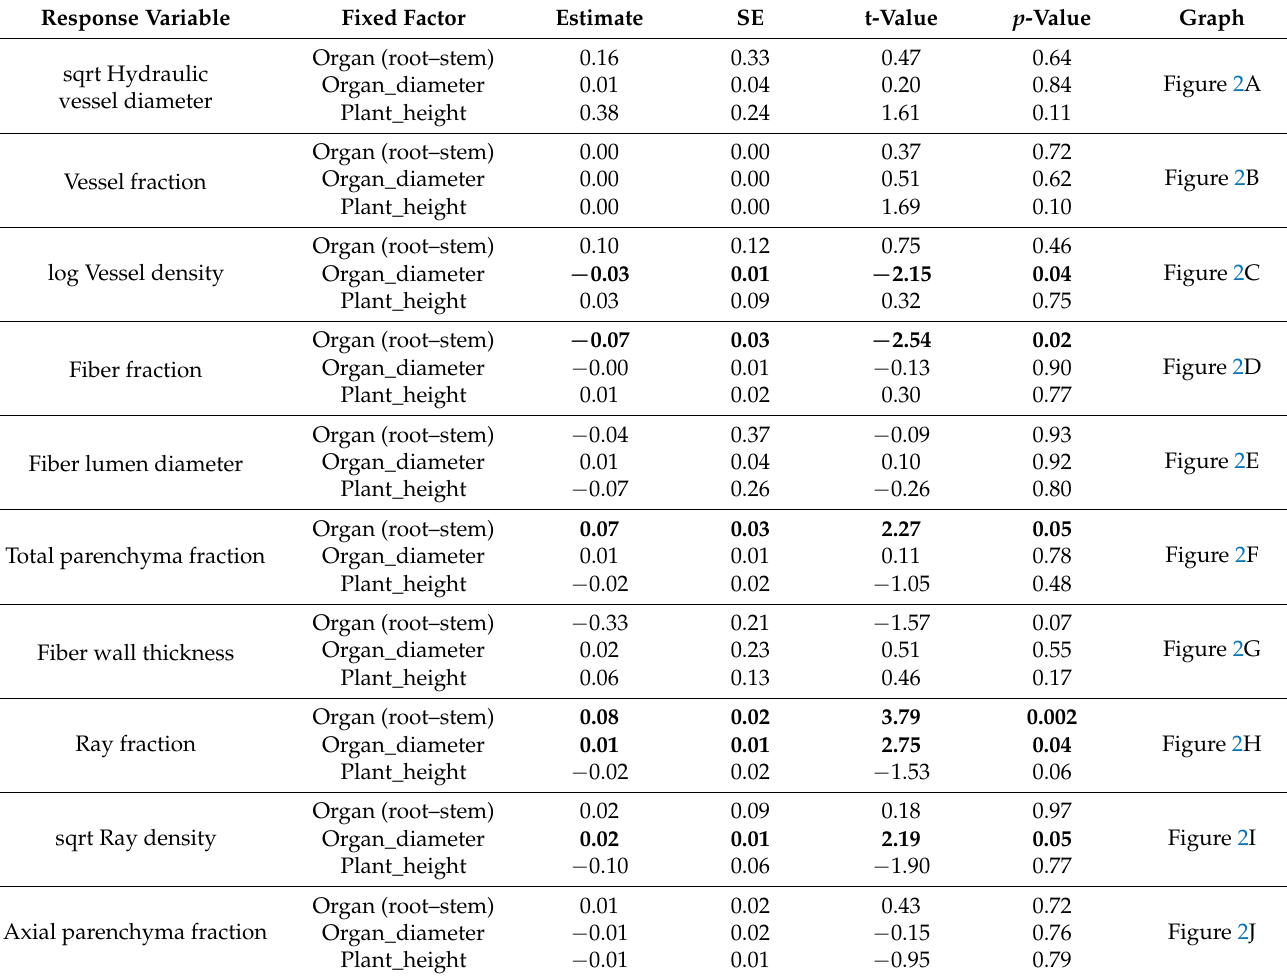
Figure 2JOrgan_diameter −